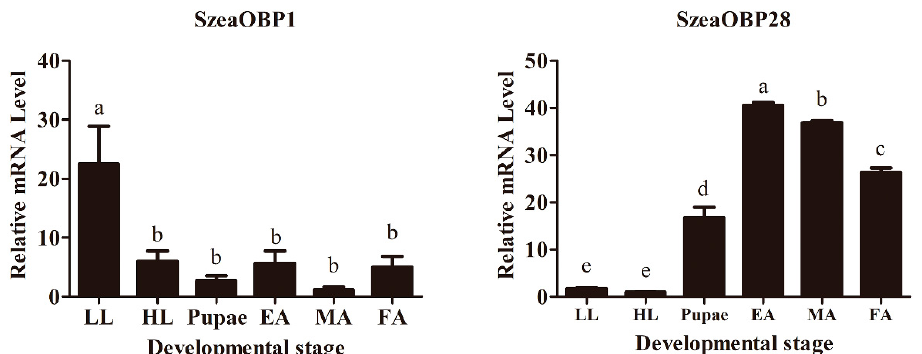
Figure 1. Relative mRNA levels. Expression patterns of various Sitophilus zeamais odorant-binding protein (OBP) genes in di ff erent developmental stages, including LL (low-instar larva), HL (high-instar larva), pupae (prepupa and postpupa), EA (eclosion adult), MA (male adult), and FA (female adult). The gene expression levels in the various tissues were normalized relative to the expression in di ff erent tissues. The data are presented as the means of three replicates ( n = 3) ± SE. Di ff erent lowercase letters indicate significant di ff erences ( p < 0.05).